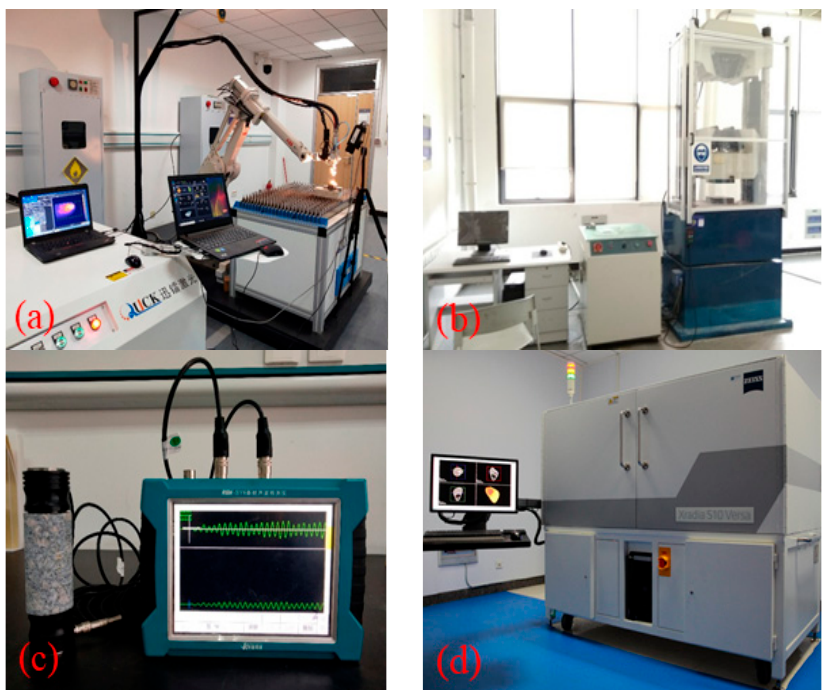
Figure 1. Devices used in experiments: ( a ) laser system, ( b ) electro-hydraulic testing servo machine, ( c ) ultrasonic tester, ( d ) X-ray micro-imaging system.